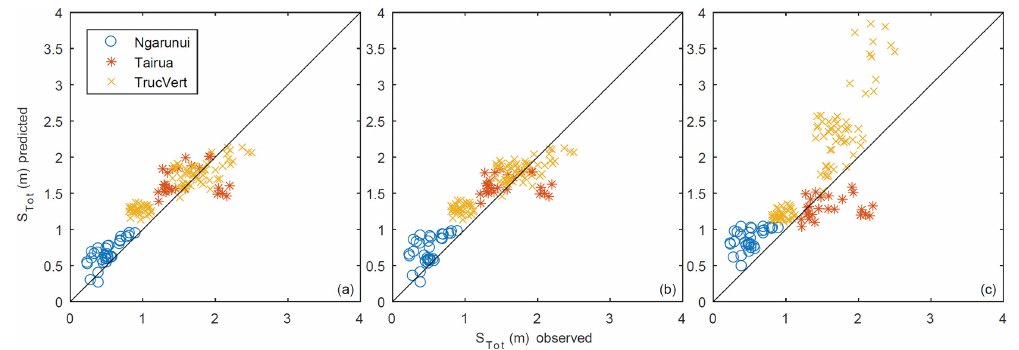
Figure 5. Observed versus predicted S Tot with the new independent data set. (a) GP Eq. (11), (b) GP Eq. (12) and (c) Stockdon et al. (2006) – Eq. (5) in this